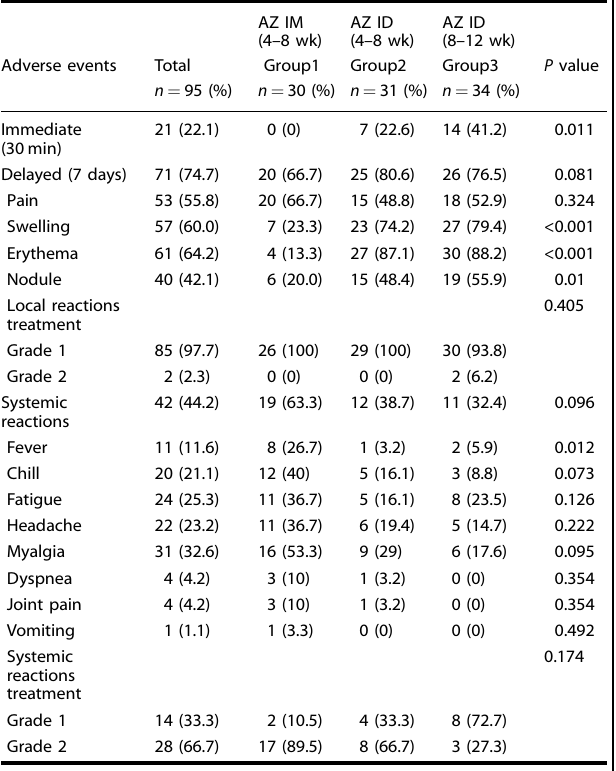
Table 2. Adverse events of the intramuscular (IM) and intradermal (ID) boosted ChAdOx1 nCoV-19 (Oxford-AstraZeneca; AZ) in the tested